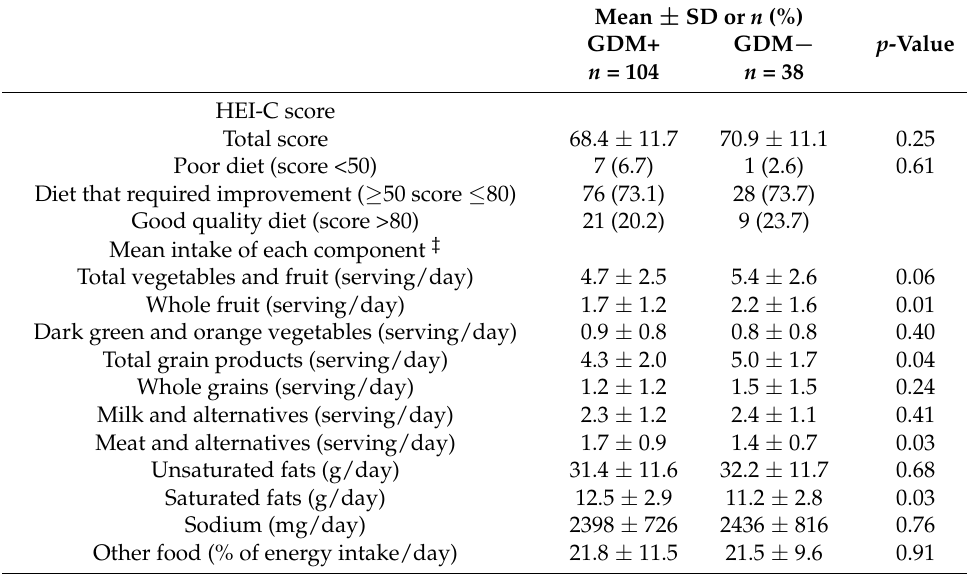
Table 2. Diet quality during